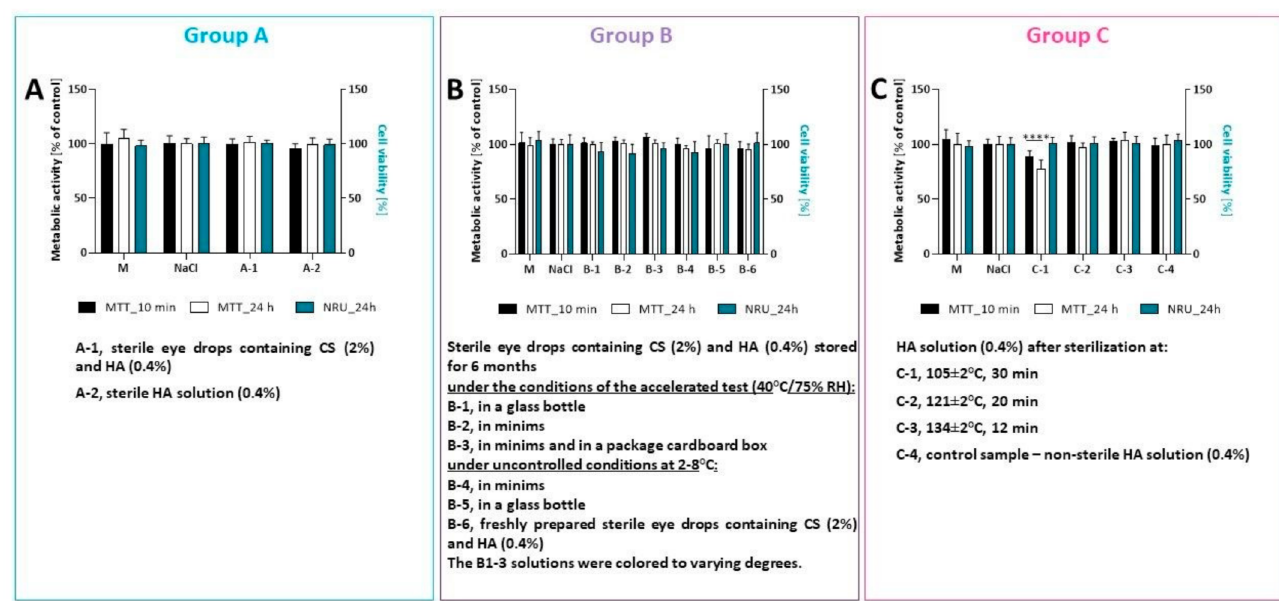
Figure 5. The effect of tested eye drops on SIRC cell viability: ( A ) cell viability after incubation with eye drops containing choline salicylate; ( B ) results for eye drops containing choline salicylate and hyaluronic acid after storage at different conditions; ( C ) data for eye drops containing hyaluronic acid and sterilized at different conditions. Sterile 0.9% NaCl was used as a control. Moreover, an additional control—cell culture medium (M) only—was also used. Cell viability was measured by MTT assay immediately after incubation with tested solutions and 24 h after incubation. Moreover, the cell viability was measured using the NRU assay (24 h after incubation with tested eye drops). Data are presented as a mean value + SD from two independent experiments. Statistical significance (****) between groups was assessed by Dunnett’s multiple comparison ( p <